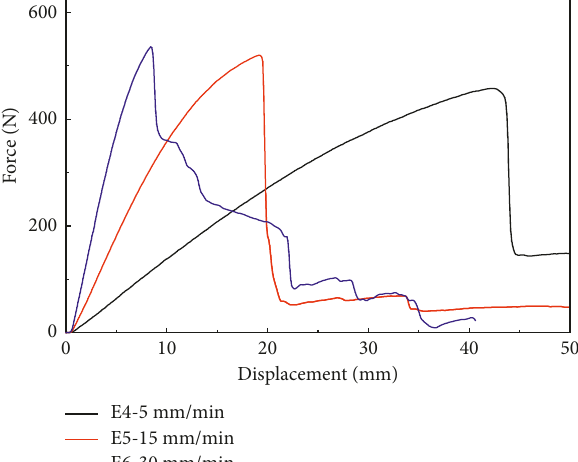
Figure 14: Load-displacement curves of specimens with different velocities on